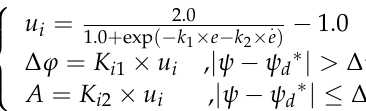
ψ Figure 5. Block diagram of the course controller. ψ d is the final desired heading angle; ψ i